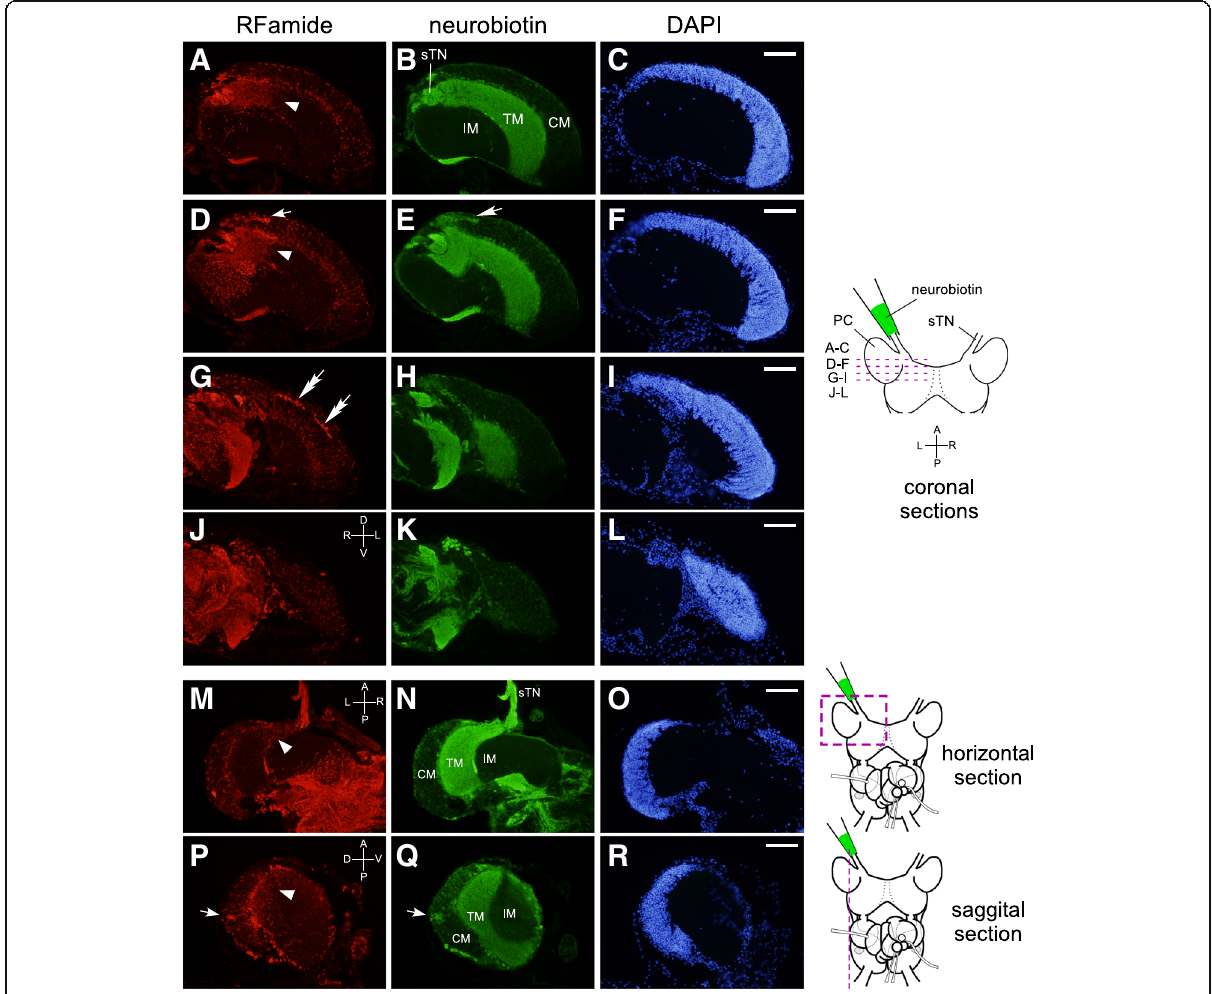
Fig. 7 Sections of the PC stained with ( a , d , g , j , m , p ) anti-RFamide antibody and ( b , e , h , k , n , q ) streptavidin that binds NB incorporated from the cut end of the superior tentacular nerve. ( c , f , i , l , o , r ) Fluorescence images of DAPI of respective left panels. White single and double arrows indicate the putative signals of PP and NP-F2, respectively. White arrowheads indicate the RFamide-positive neuropil region in the TM. The schema on the right indicates the cutting plane of the sections. Scale bars: 100 μ m (applicable to the photographs in the left). sTN, superior tentacular nerve; CM, cell mass; TM, terminal mass; IM, internal mass, D, dorsal; V, ventral; A, anterior; P, posterior; R, right; L,